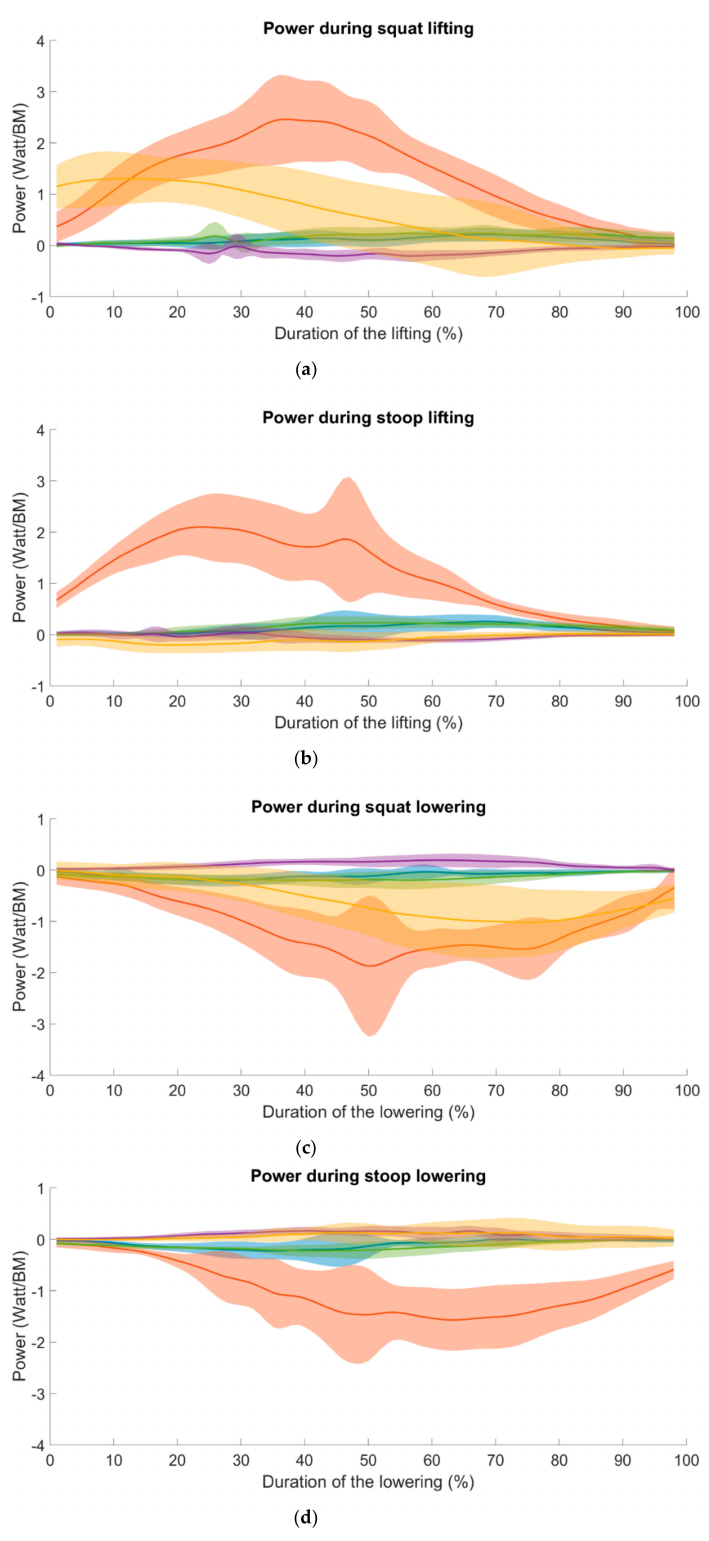
Figure 3. Joint power of the five di ff erent joints (L5S1 (blue), hip (red), knee (yellow), shoulder (purple) and elbow (green)) during the two di ff erent lifting techniques (stoop and squat) with a load equal to 40% ALST. Shaded areas indicate standard deviations. ( a ) Joint power during squat lifting; ( b ) joint power during stoop lifting; ( c ) joint power during squat lowering; ( d ) joint power during stoop